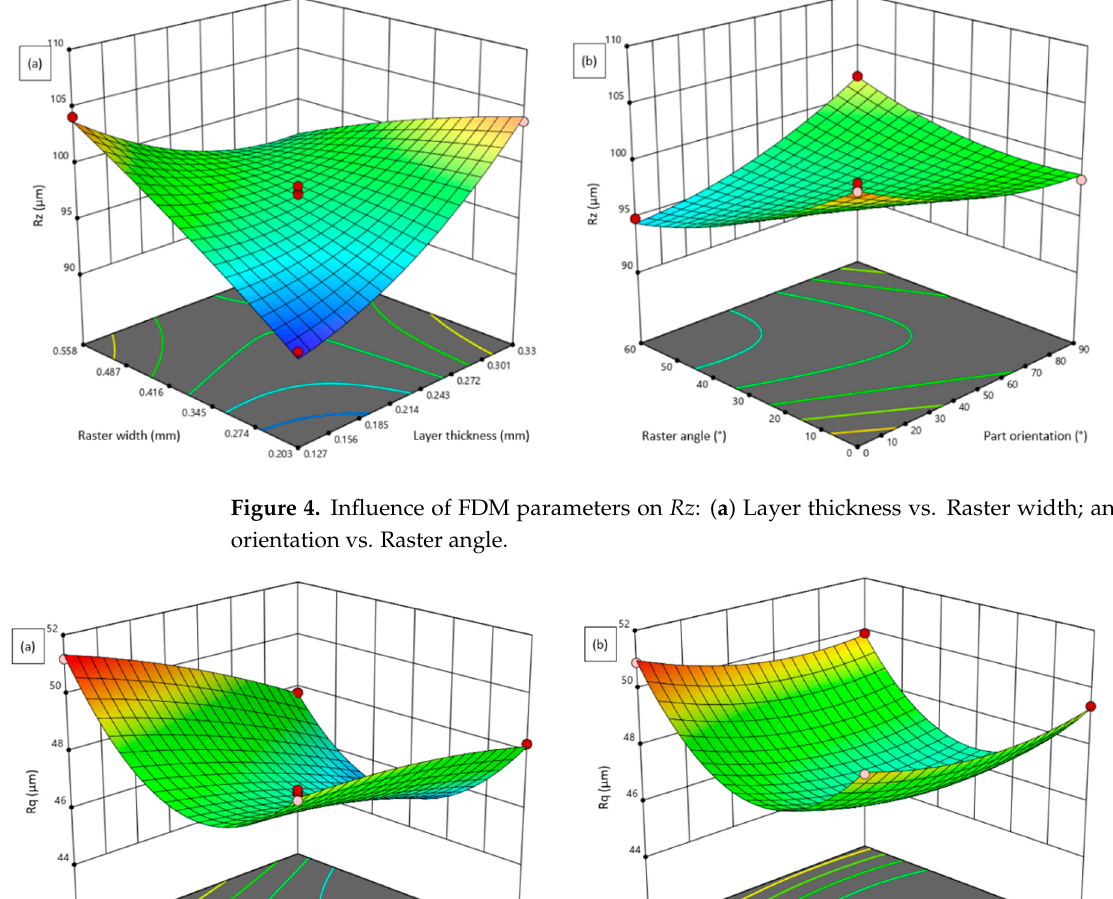
11 of 18 Figure 3. Influence of FDM parameters on Ra: ( a ) Layer thickness vs. Part orientation; ( b ) Layer thickness vs. Raster angle; and ( c ) Part orientation vs Raster width The influence of part orientation on the surface quality characteristics is demon- strated in Figures 3a,c and 4b. It is evident from the surface plots that the roughness values slightly increased when the parts were fabricated at 45° orientation, whereas the speci- mens fabricated at 0° and 90° orientation were found to be of better surface quality. When the parts were fabricated at an inclined orientation, the staircase effect increased and thus the roughness increased, whereas the specimens fabricated with horizontal and vertical orientations had significantly improved surface quality parameters despite the complex part profiles [28,29]. The consequences of varying the width of the deposited layer of pat- tern or raster width are depicted in response surfaces shown in Figures 3c, 4a and 5b. It is